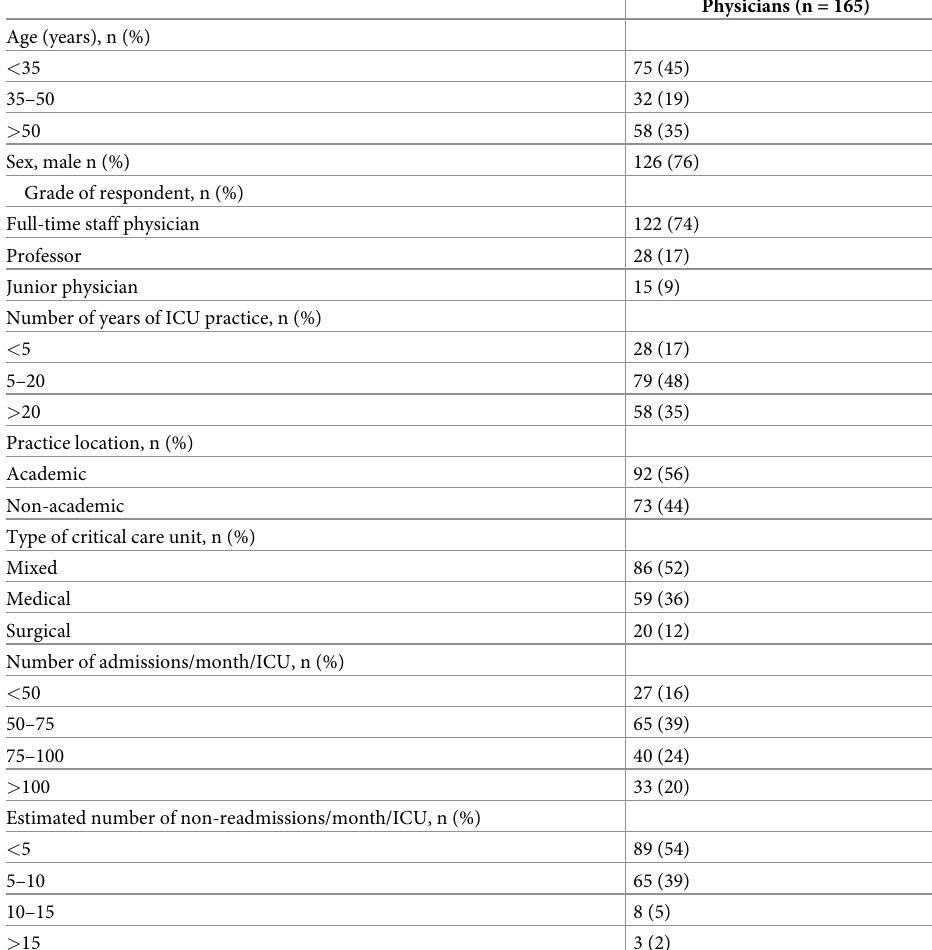
Table 2. Characteristics of the intensive care units and intensive care physicians who responded to the